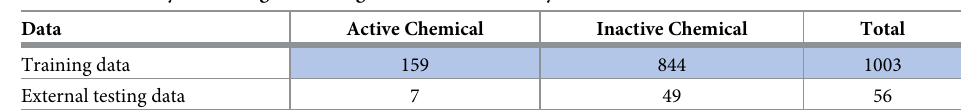
Table 1. Summary of training and testing data used in this